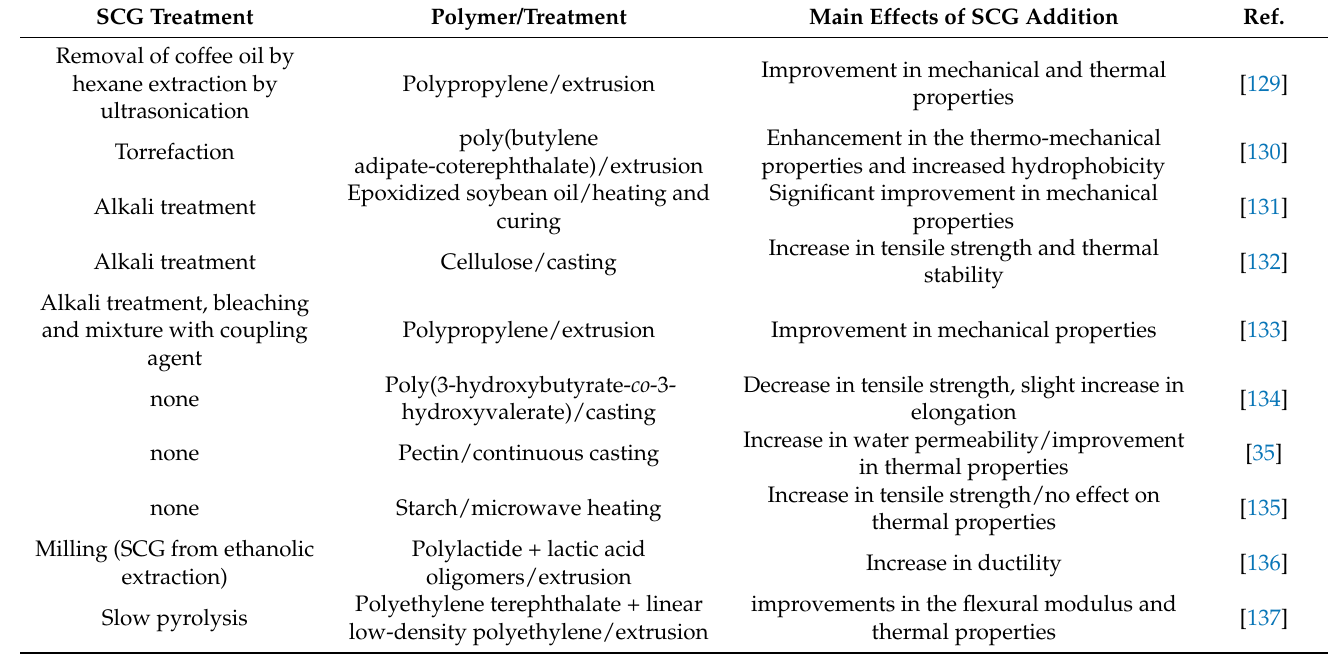
Table 3. Some recent applications of SCG as fillers in polymers.